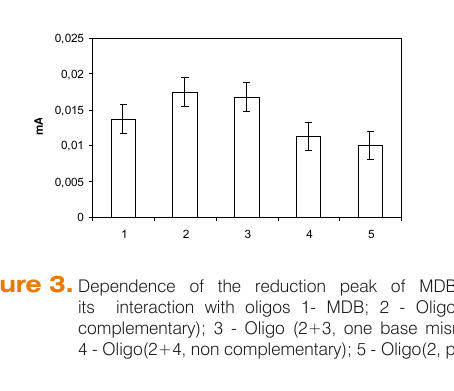
Figure 2. Cyclic voltammogram of proflavine.